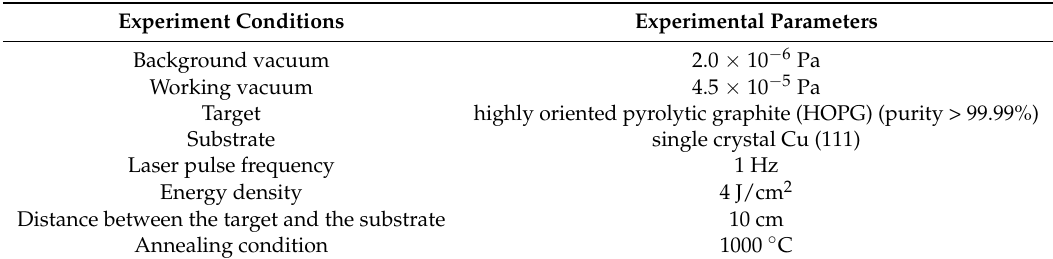
Table 1. Experimental fabrication parameters.